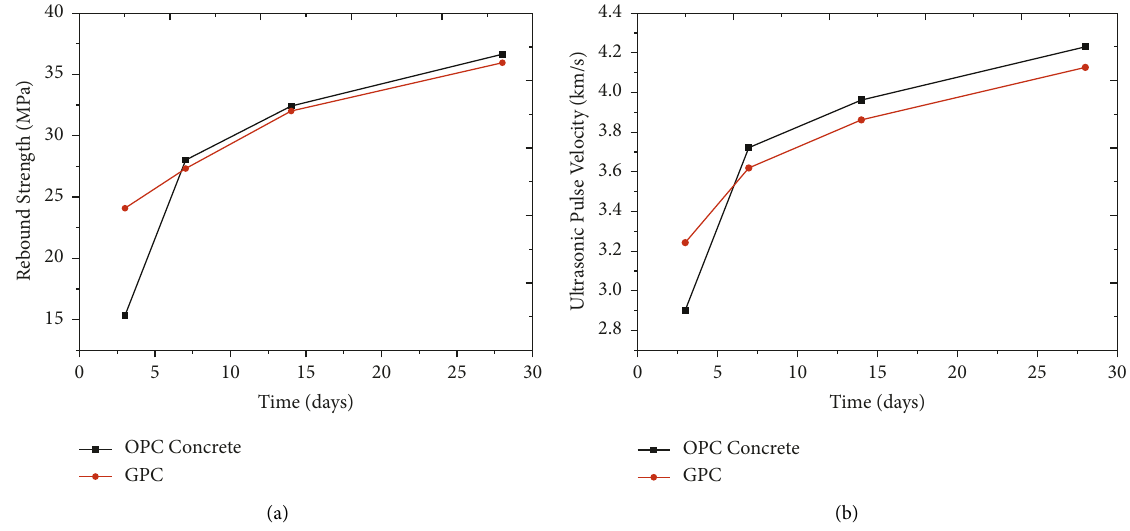
Figure 7: (a) Graph of OPC concrete and GPC rebound strength; and (b) graph of OPC concrete and GPC UPV test.